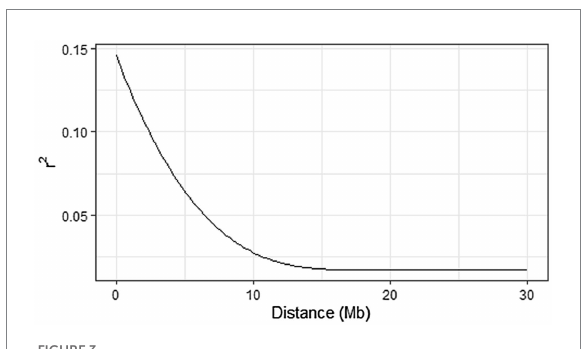
FIGURE 3 Genome-wide linkage disequilibrium (LD) decay (in Mb) in 214 potato clones using LD. plot function in GWASpoly. A monotone decreasing, convex spline was fit using the R package